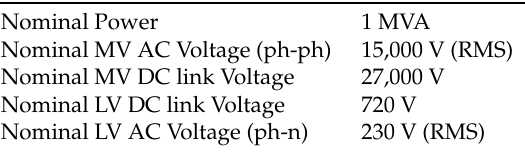
Table 2. Smart Transformer: main parameters.